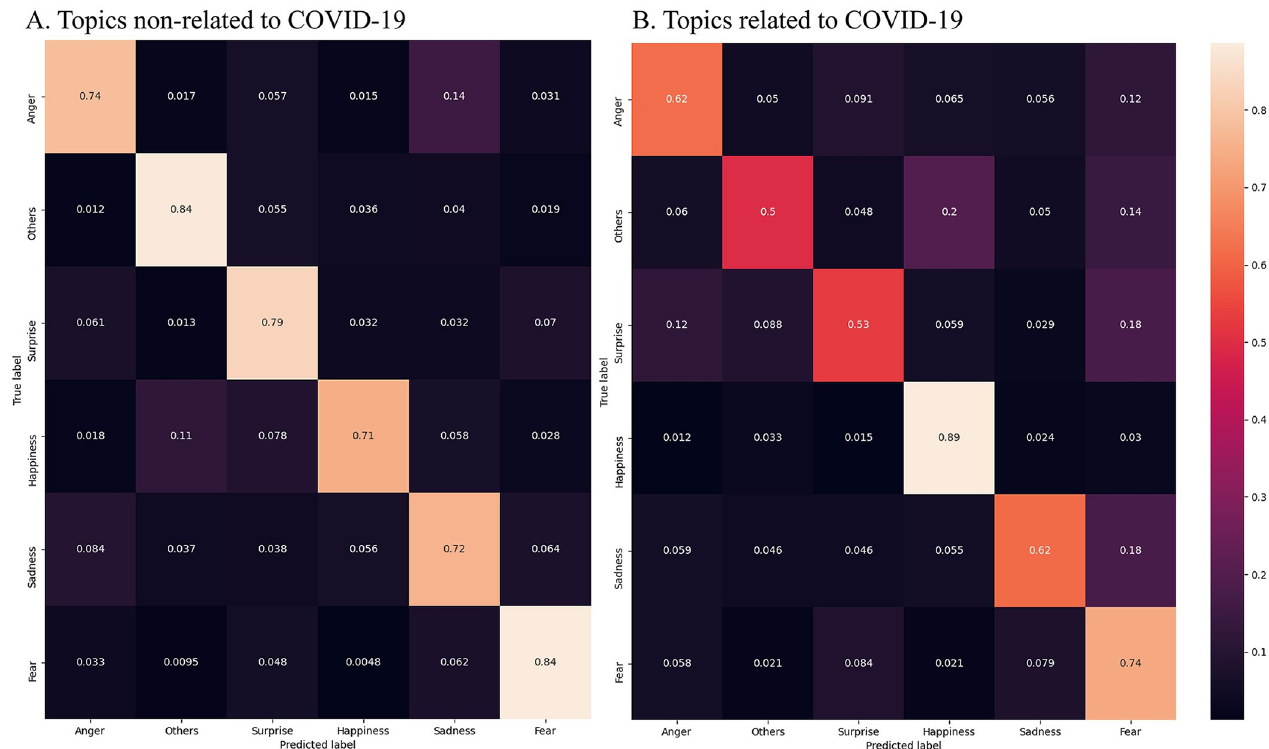
Fig 2. Confusion matrixes of the model performance. The figures display the performance of the deep learning model of detecting each of the six emotions considered in the study. Panel A (left) shows the proportions of posts correctly classified in topics that do not relate to COVID-19, and Panel B (right) displays the performance in topics that relate to the COVID-19